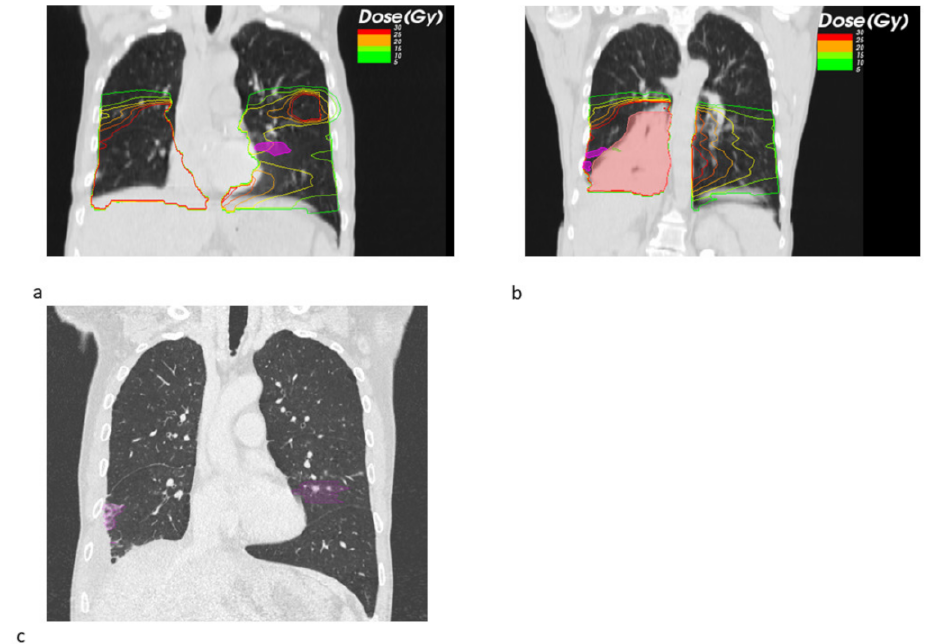
Figure 3. Sagittal radiotherapy (RT) planning CT slices showing the sum EQD2 isodoses and pneumonitis contours (magenta) for a SBRT+ ICB case ( a ). The same patient received simultaneous contralateral hypofractionated mediastinal RT with original isodoses revealing a relevant lung dose ( b ). Exemplary sagittal slice from the follow-up CT showing the bilateral pneumonitis and its contours (magenta) ( c